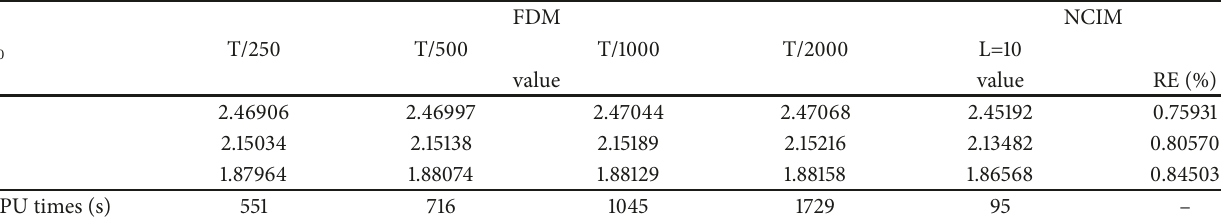
Table 7: Comparison results (option values, relative errors and CPU